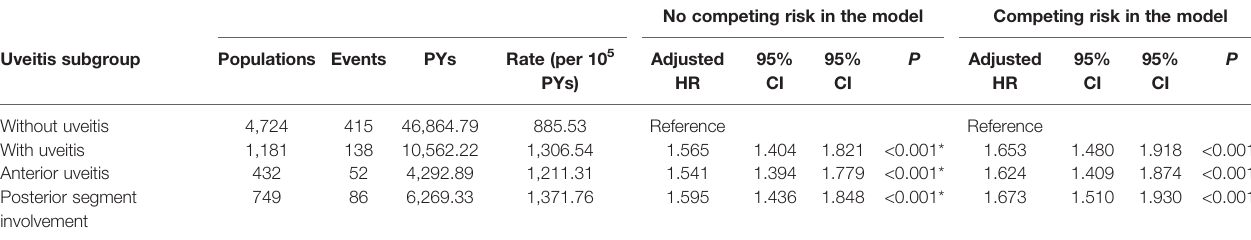
TABLE 4 | Factors for AMI among different uveitis subgroup evaluated by Cox regression with/without Fine & Gray ’ s competing risk model. No competing risk in the model Competing risk in the